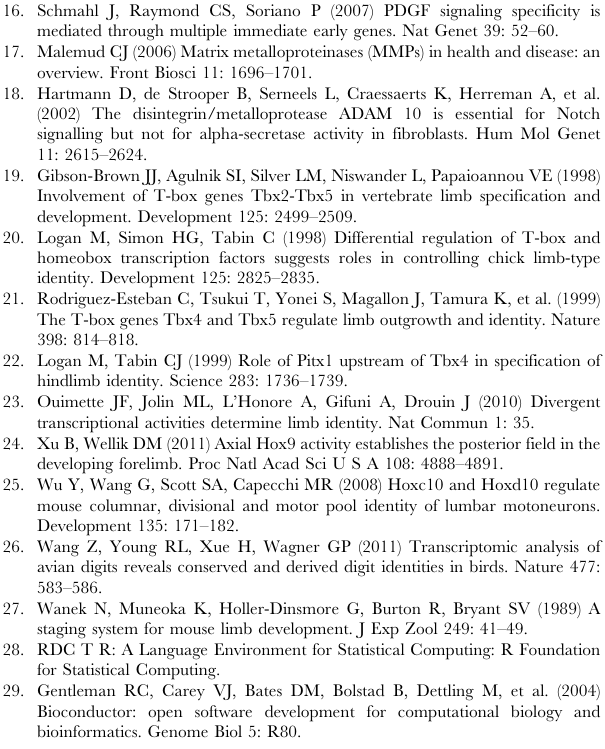
Figure S2 Whole Embryo and Limb Average Expression Values. Whole embryo expression values are independent of whether a gene is up-regulated or not in the limb (P- value = 0.4 6 10 2 13, Wilcoxon rank sum test). Solid lines represent expression distribution for limb and dashed lines for whole embryo [all (green); up-regulated in limb (black); not up- regulated (red)]. Figure S3 Whole Embryo and Limb Normalized Log2 Expression Values for Oscillating Genes. The log2 expression values were normalized for each gene such that the mean and standard deviation across all arrays are 0 and 1, respectively. The height of the bar represents the average of this normalized expression value for each sample. Whole embryo expression is visualized by black bars and limb expression by red bars. Each cluster (A) On E10.5, E12.5; (B) On E10.5, E13.5; (C) On E9.5, E11.5; (D) Off E9.5, E11.5; (E) Off E12.5, has whole embryo values below 0 (except for E13.5 in panel C), suggesting that whole embryo expression is very low relative to limb expression which is dominantly above 0. Table S1 Top 100 upregulated genes. Table S2 Expression values for genes known to function during limb development, or family members of signal